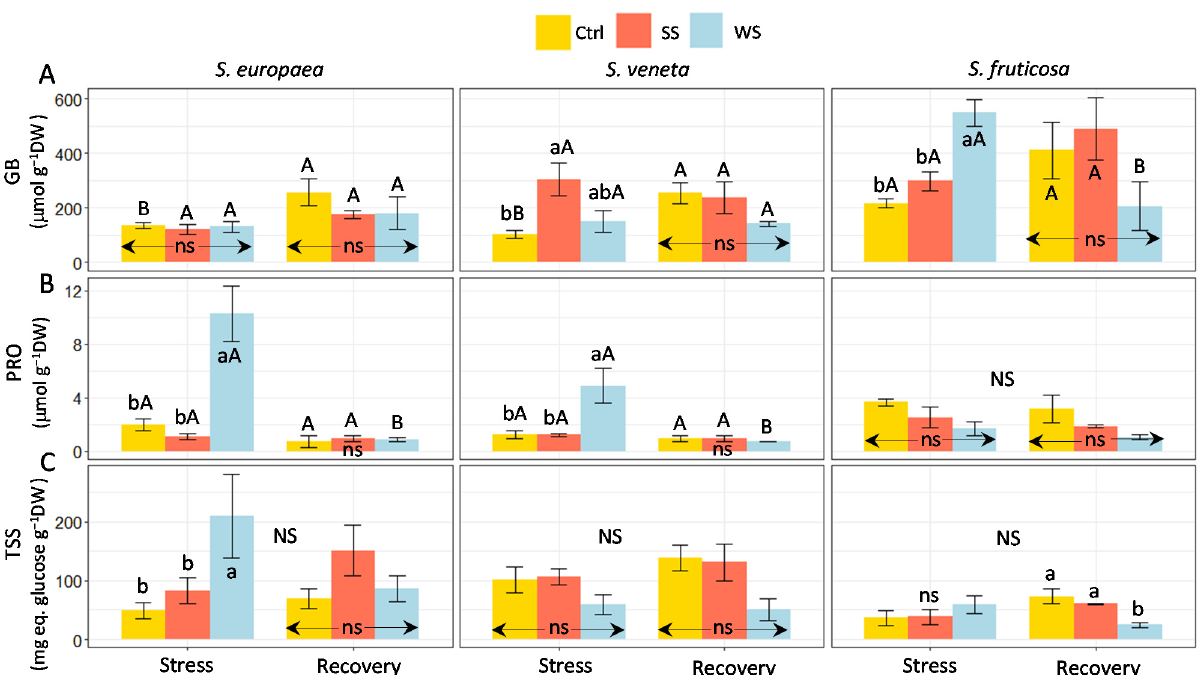
Figure 5. Effect of 30 days of stress treatments (Stress) followed by watering with non-saline water for 15 days (Recovery) on shoot concentration of ( A ) glycine betaine (GB), ( B ) proline (PRO), and ( C ) Total Soluble Sugars (TSS) in the three halophytes. Ctrl, control; SS, salt stress (watering with 700 mM NaCl); WS, water stress (complete withholding of irrigation). For each species and sampling (Stress or Recovery), different lowercase letters over the bars indicate significant differences between treatments (Ctrl, SS, and WS), at p ≤ 0.05; ns: non-significant. Different uppercase letters indicate significant differences between the two samplings (Stress and Recovery) for each species and treatment, at p ≤ 0.05; NS: non-significant. Vertical bars indicate standard error ( n = 4).